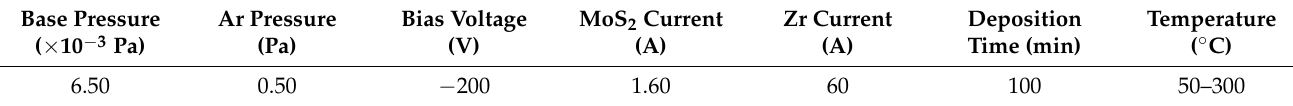
Table 1. Prepare conditions of MoS 2 -Zr coatings at different deposition